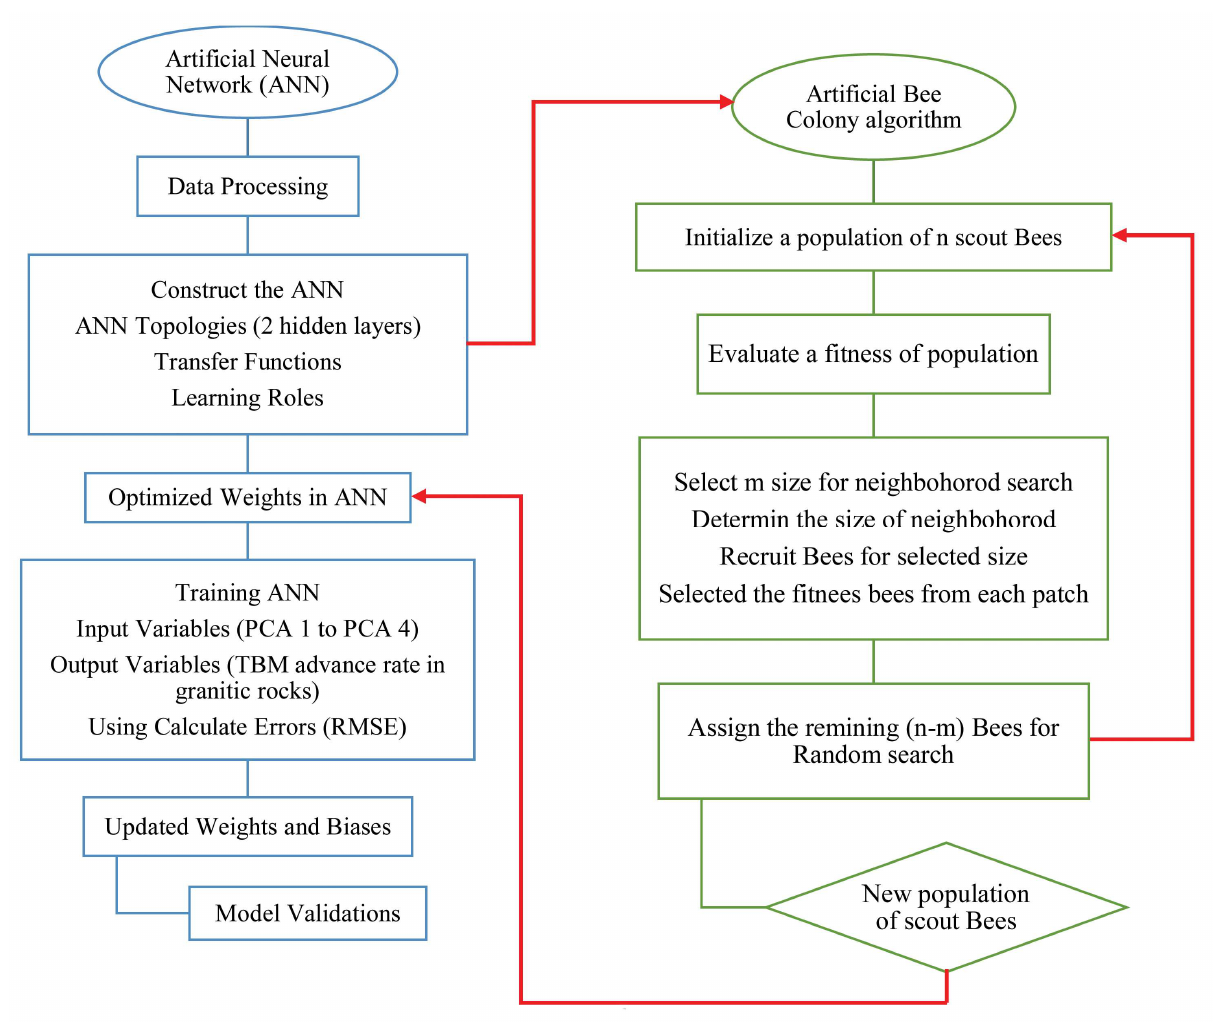
Figure 1. Flowchart of a hybrid ANN optimized with the Artificial Bee Colony algorithm.